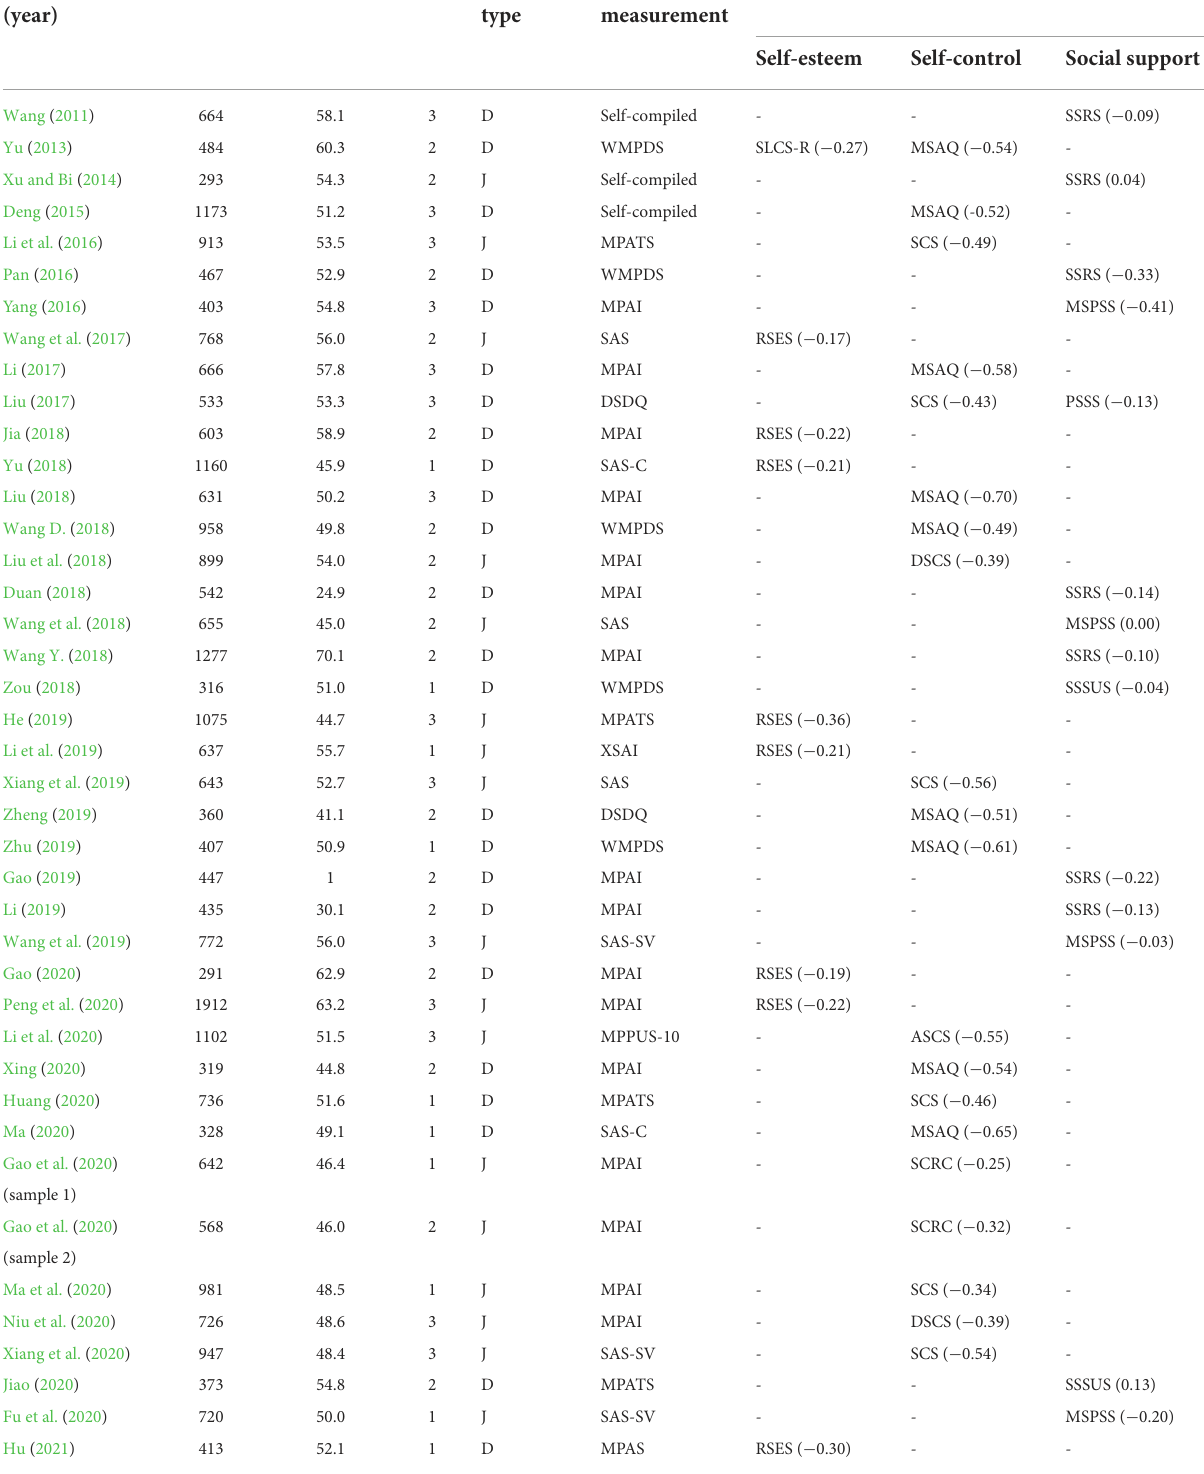
TABLE 1 Characteristics of the 56 studies included in the